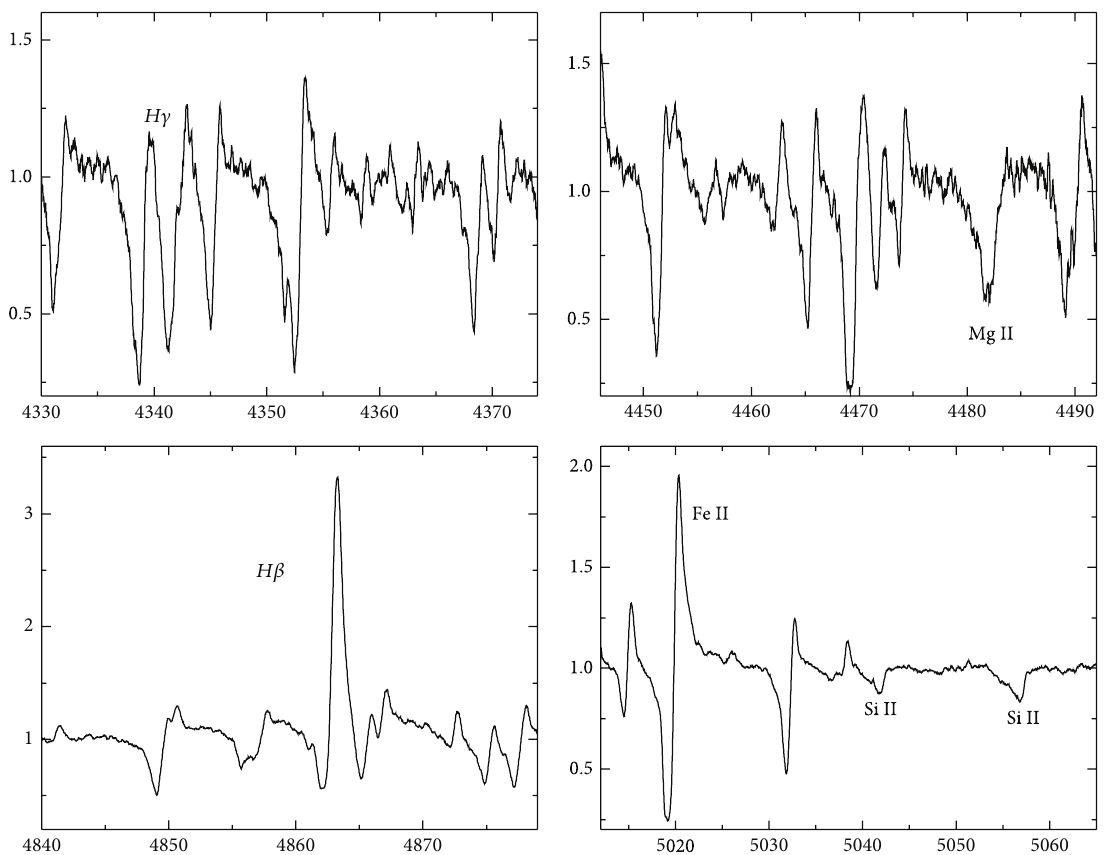
Figure 3: Parts of the CFHT spectrum of MWC 930 obtained on 2012 June 29. The intensity and wavelengths are in the same units as in Figure